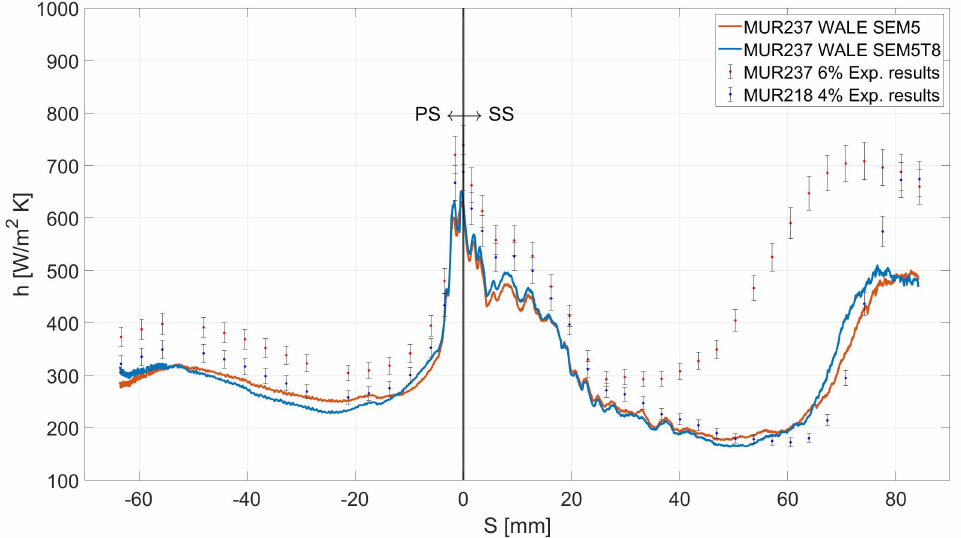
Figure 8. Influence of the turbulence intensity: convective heat transfer